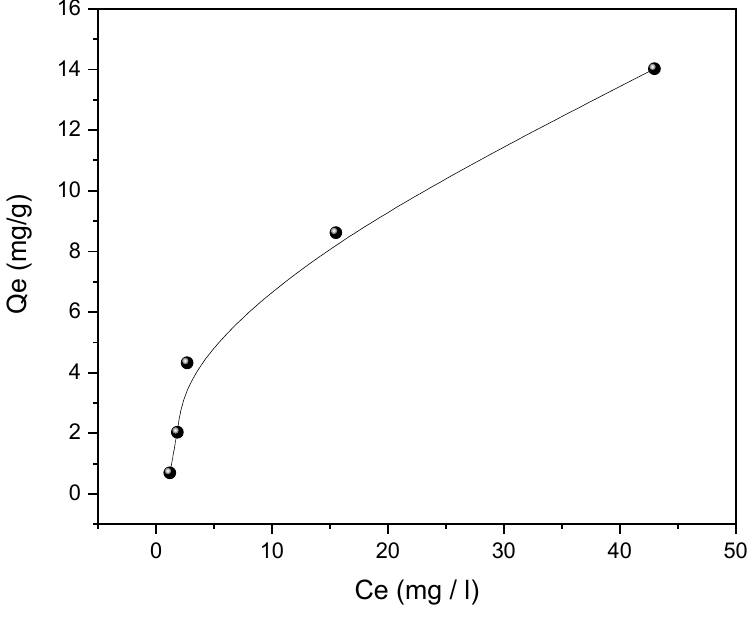
Figure 15. Adsorption isotherm of BR on to ALP.